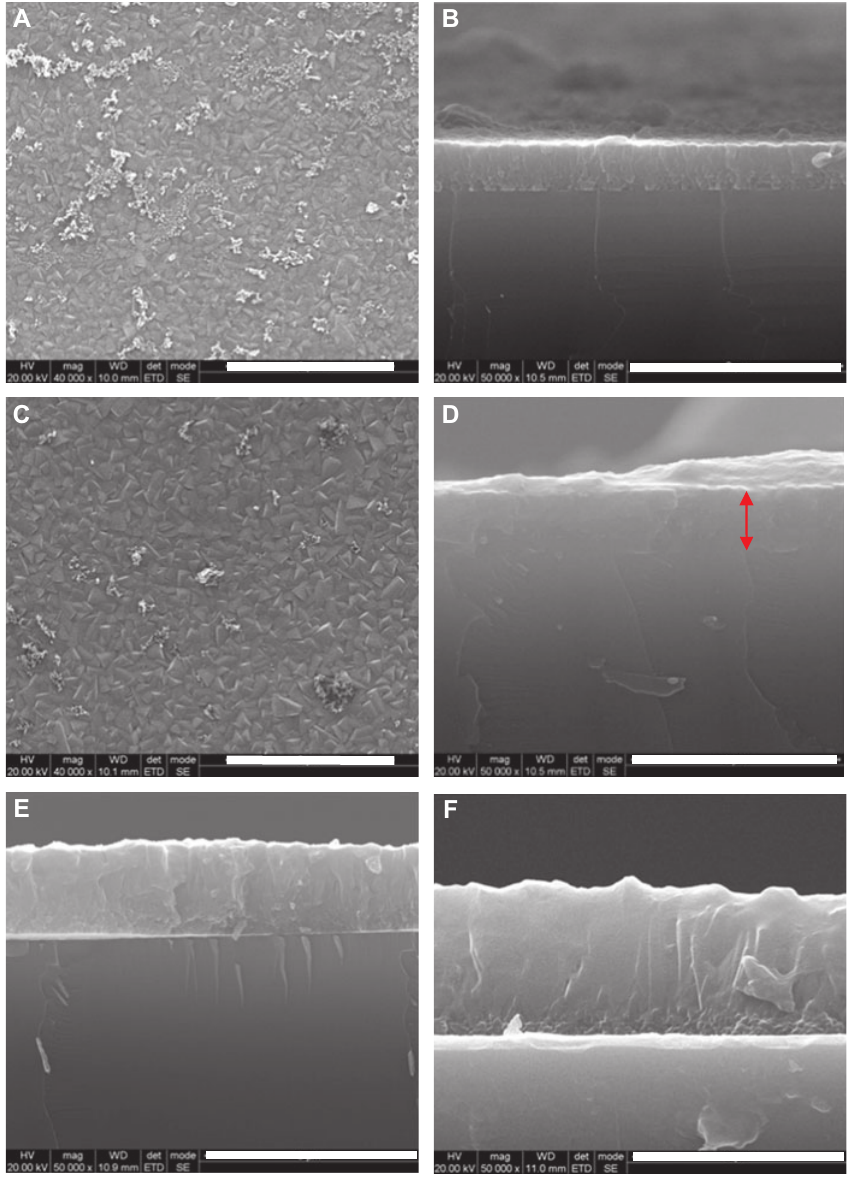
Figure 2 SEM images, ruler corresponds to 3 microns, of zeolite coatings on a thermally oxidized silicon wafer after hydrothermal micro- wave synthesis at different times: (A), (B) 3 min top view and cross section, (C), (D) 6 min top view and cross section, (E) 10 min cross section and (F) 30 min cross